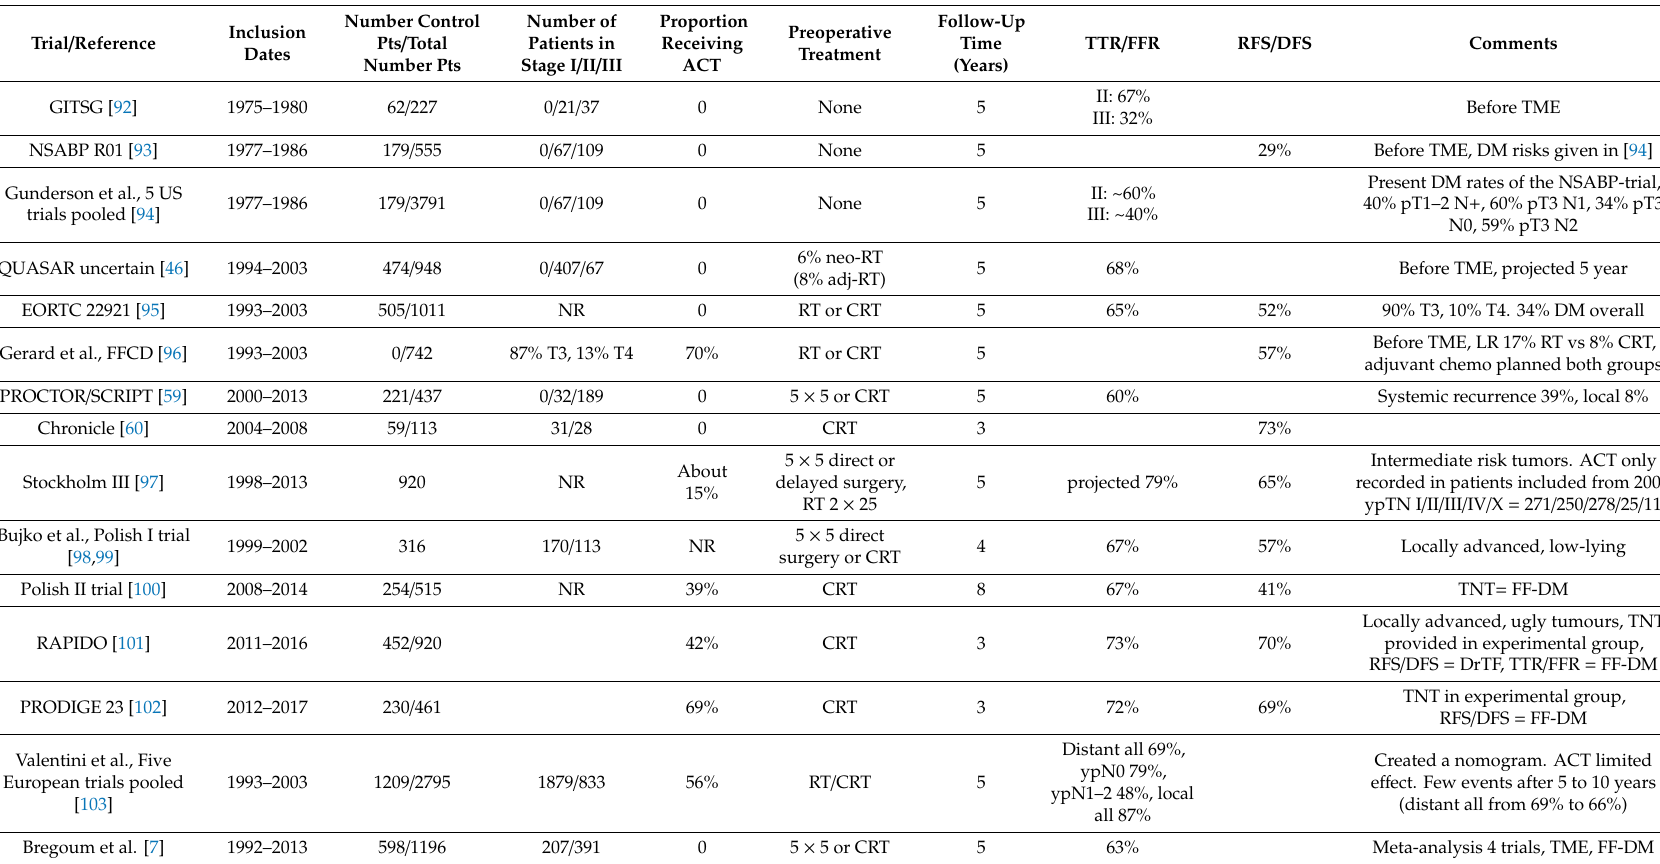
Table 3. Time to recurrence rate / freedom from recurrence and recurrence-free or disease-free survival in adjuvant trials in rectal cancer with a surgery alone group and where systemic chemotherapy was provided in the experimental